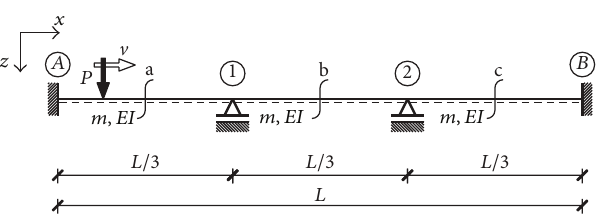
Figure 15: Three-span continuous uniform beam loaded with mov- ing force.